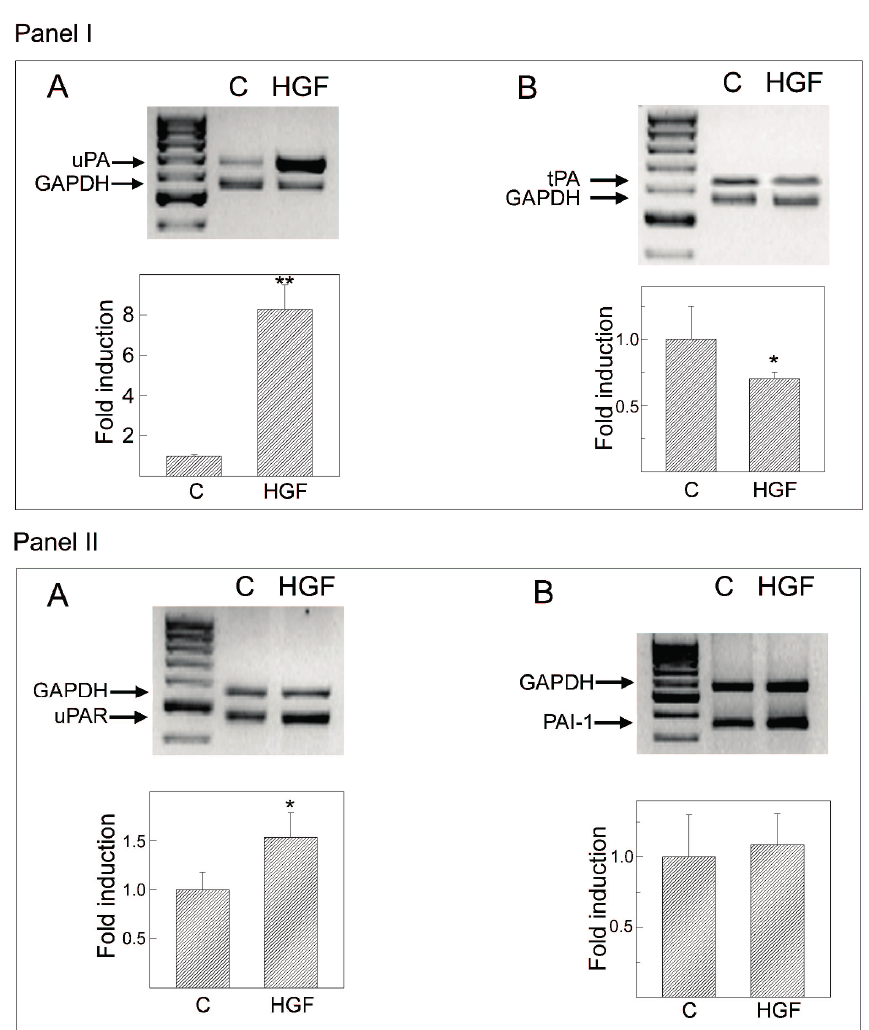
Figure 7. uPA , tPA , uPAR and PAI-1 gene expression level after HGF administration. ( Panel I ): The effect of HGF stimulation on uPA ( A ) and tPA ( B ) gene expression, as detected by multiplex RT-PCR. Myoid cells were cultured for 24 h in medium alone C or in the presence of 150 U/mL (45 ng/mL) HGF. Total RNA was subjected to RT-PCR, and aliquots of the PCR products were electrophoresed on a 1.5% agarose gel ( top ). The values of the uPA and tPA PCR products were normalized to their corresponding GAPDH values and are expressed as fold induction with respect to C, which was arbitrarily set to one. Values represent the mean ± SEM of three separate experiments. * p < 0.05; ** p < 0.001. ( Panel II ): The effect of HGF stimulation on uPAR ( A ) and PAI-1 ( B ) gene expression as detected by multiplex RT-PCR. Myoid cells were cultured for 24 h in medium alone C or in the presence of 150 U/mL (45 ng/mL) HGF. Total RNA was subjected to RT-PCR, and aliquots of the PCR products were electrophoresed on a 1.5% agarose gel ( top ). The values of uPAR and PAI-1 PCR products were normalized to their corresponding GAPDH values and are expressed as fold induction with respect to C, which was arbitrarily set to one. Values represent the mean ± SEM of three separate experiments. * p <